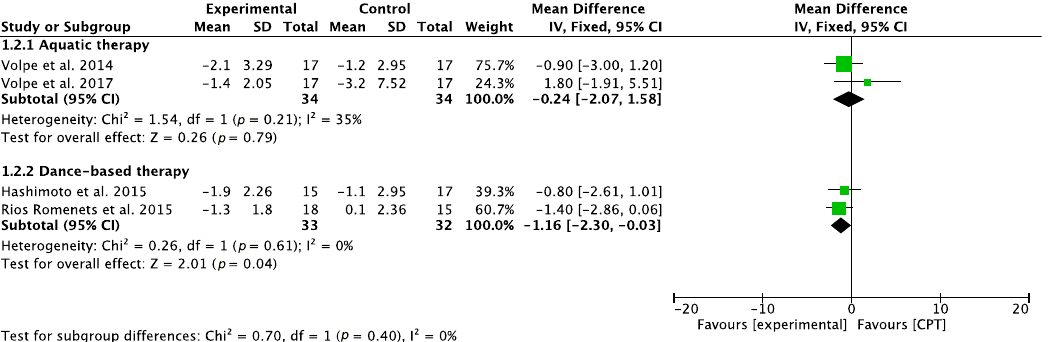
Figure 3. Forest plot for motor balance measured by TUG. Green block indicates the weight assigned to the study and the horizontal line depicts the confidence interval. Black rhombus shows the overall result. The bold words highlight the total/subtotal values and the different modalities of therapies used in the interventions. J. Clin. Med. 2020 , 9 , x FOR PEER REVIEW